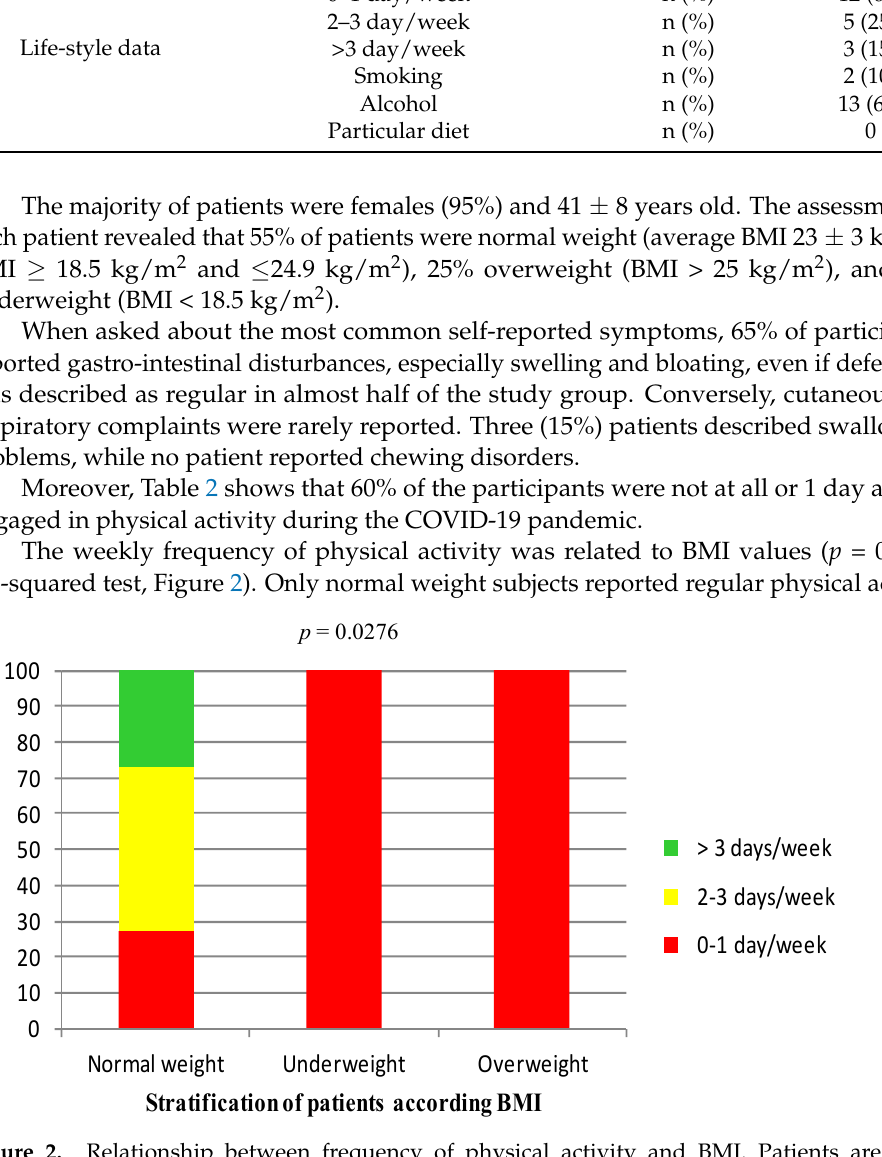
Table 3. Dietary behaviours at baseline of SNAS patients during COVID-19 pandemic.